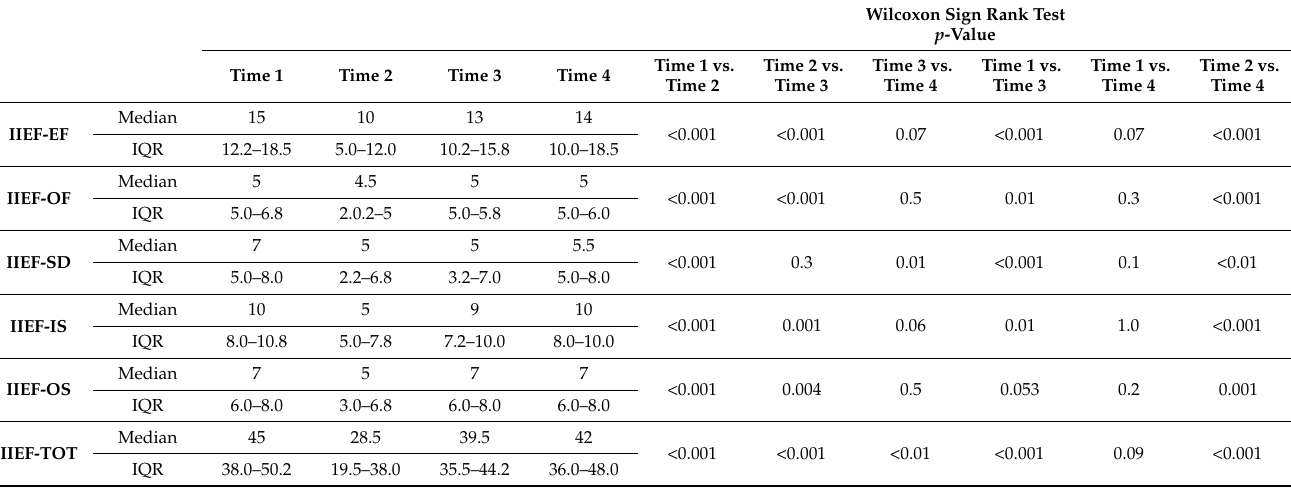
Table 5. International index of erectile function (IIEF) questionnaire administrated to 22 COVID-19 patients in the periods before COVID 19 testing (Time 1), during quarantine (Time 2), 1 month after a negative test (Time 3), and 3 months after a negative test (Time